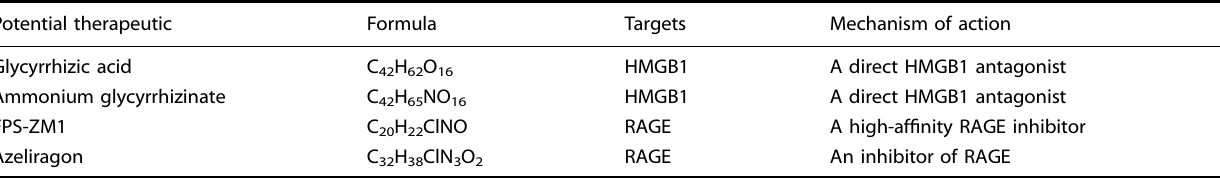
Table 5. Potential therapeutic tools for inhibiting HMGB1-RAGE/TLR4 signaling during COVID-19